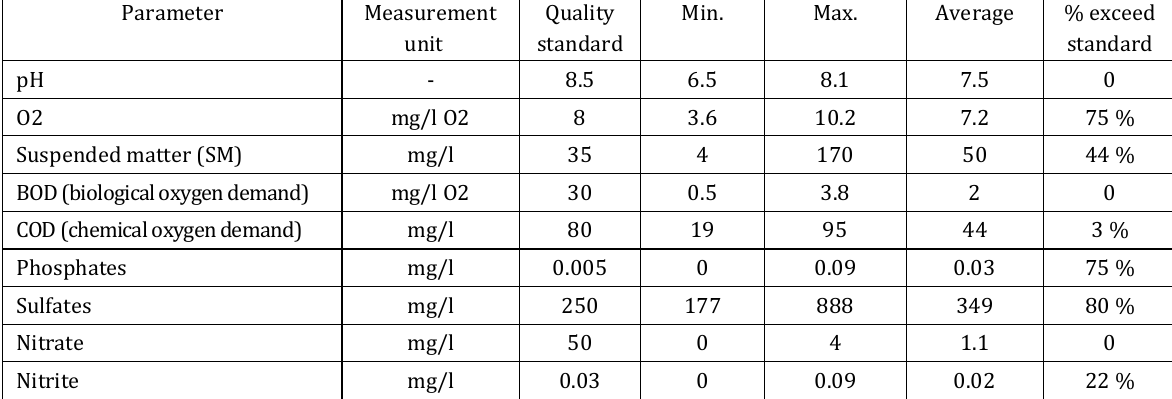
Table 4. Standards values of the used parameters (Milijašević et al. 2011) Parameter